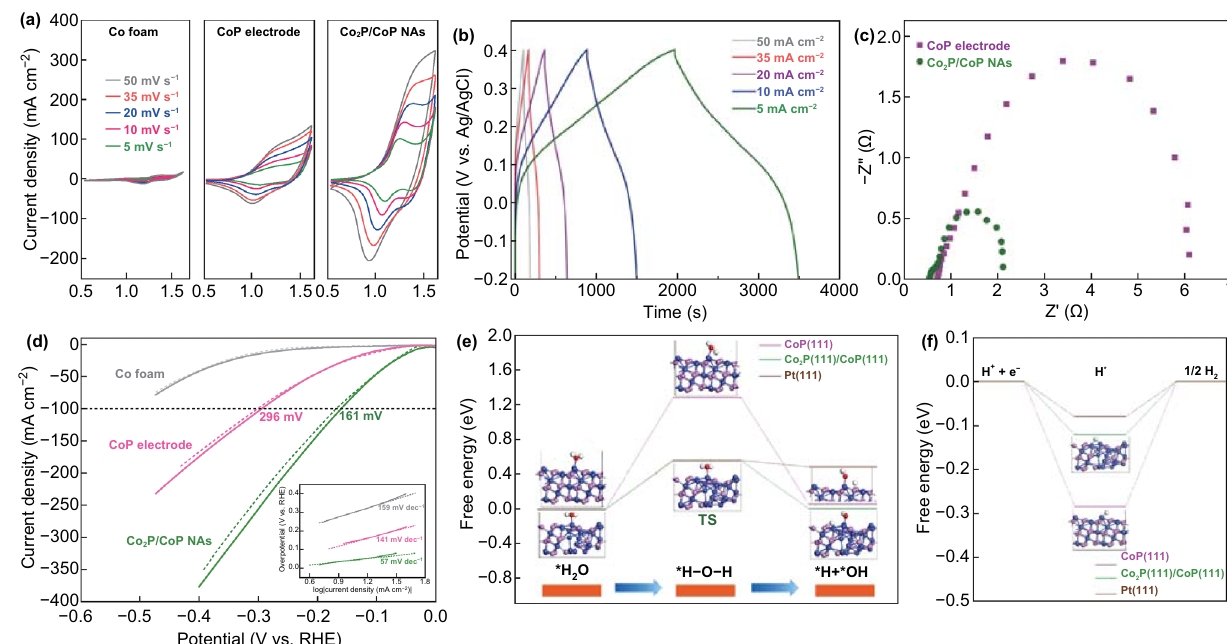
Fig. 3 a CV curves of blank CF, pure CoP and Co 2 P/CoP NAs electrodes at different scan rates in 1 M KOH electrolyte. b Charge/discharge curves of Co 2 P/CoP NAs at various current densities. c Nyquist impedance spectra of pure CoP and Co 2 P/CoP NAs electrodes. d LSV curves for the Co‑based electrodes for the H 2 evolution at a scan rate of 2 mV s −1 in 1 M KOH solution (thick line) and ammonia‑containing solution (fine line). Calculated adsorption free energy diagram for e water dissociation and f H adsorption potential on pure CoP (111), Co 2 P(111)/CoP(111) and Pt (111), respectively. Blue balls: Ni; pink balls: P; red balls: O. (Color figure